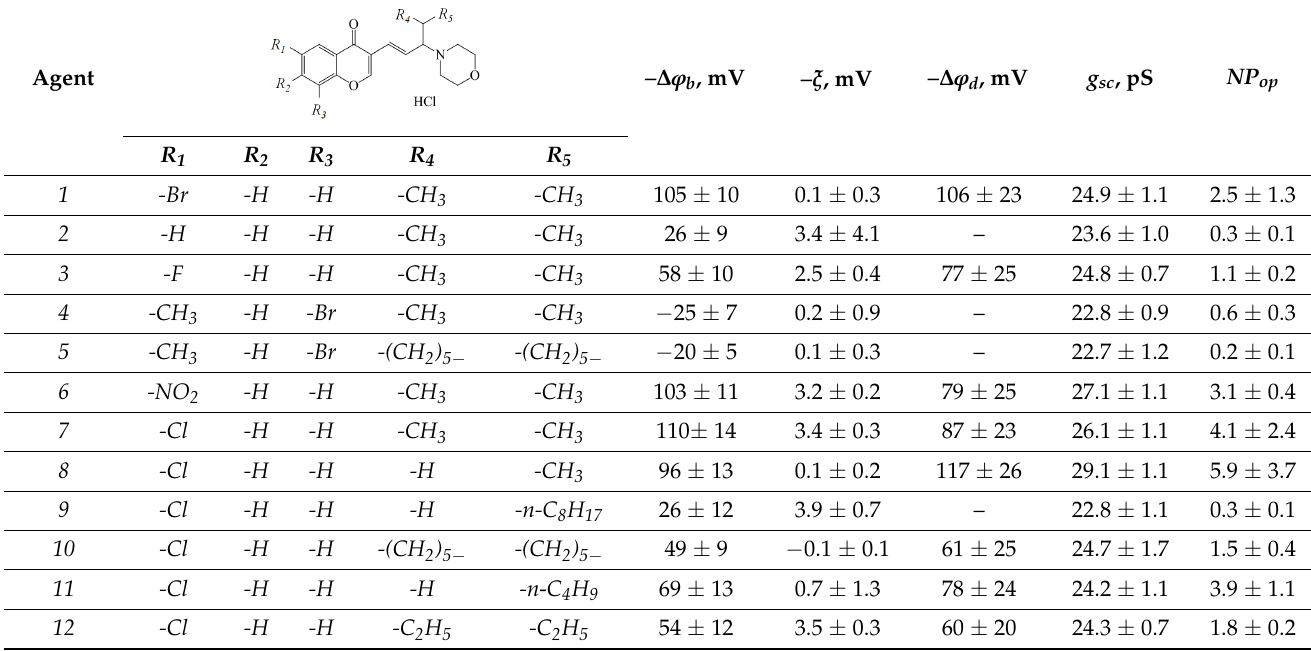
Table 1. The characteristic parameters of the action of the tested chromone-containing allylmor- pholines on the electrical properties of the POPC membranes and gramicidin A channels at 100 µ g/mL.